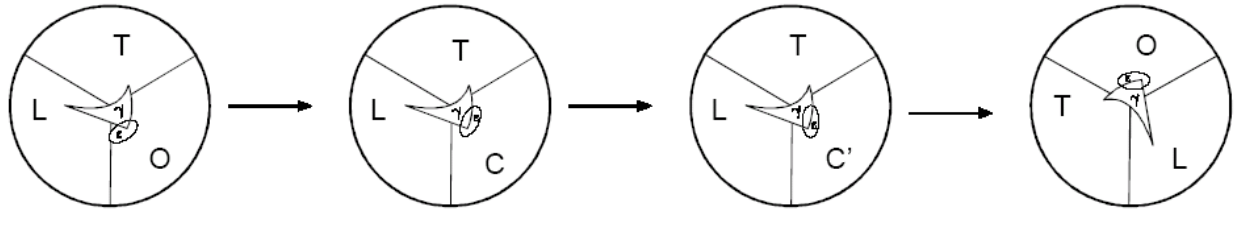
Figure 2. The torsional mechanism of energy transduction and ATP synthesis in the F portion of ATP synthase. The bound nucleotide occupancies of the catalytic sites during ATP synthesis are: no bound nucleotide in O, MgADP in C, MgADP + P in L, and MgATP in T. The diagram is drawn for one-third of the complete enzymatic cycle. Note that mismatch is removed only after the complete enzymatic